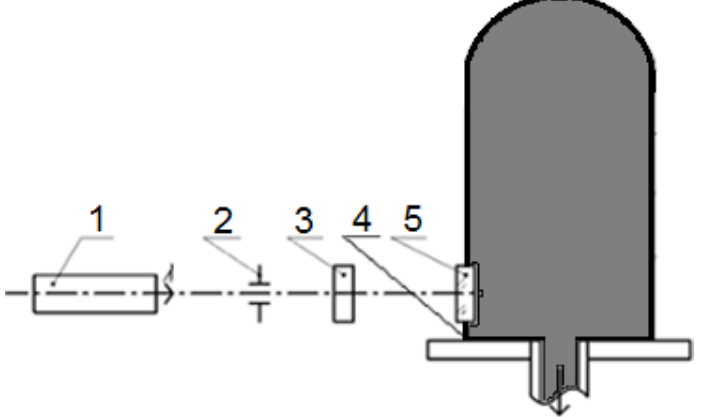
Figure 1. Short presentation of the used setup: 1—CO 2 -laser ( λ = 10.6 microns); 2—diaphragm, 3—prison; 4—vacuum post (inside which the CNTs are deposited in the vertical position on the chosen samples when using a grid with a voltage); 5—a panel of KCl single crystal.